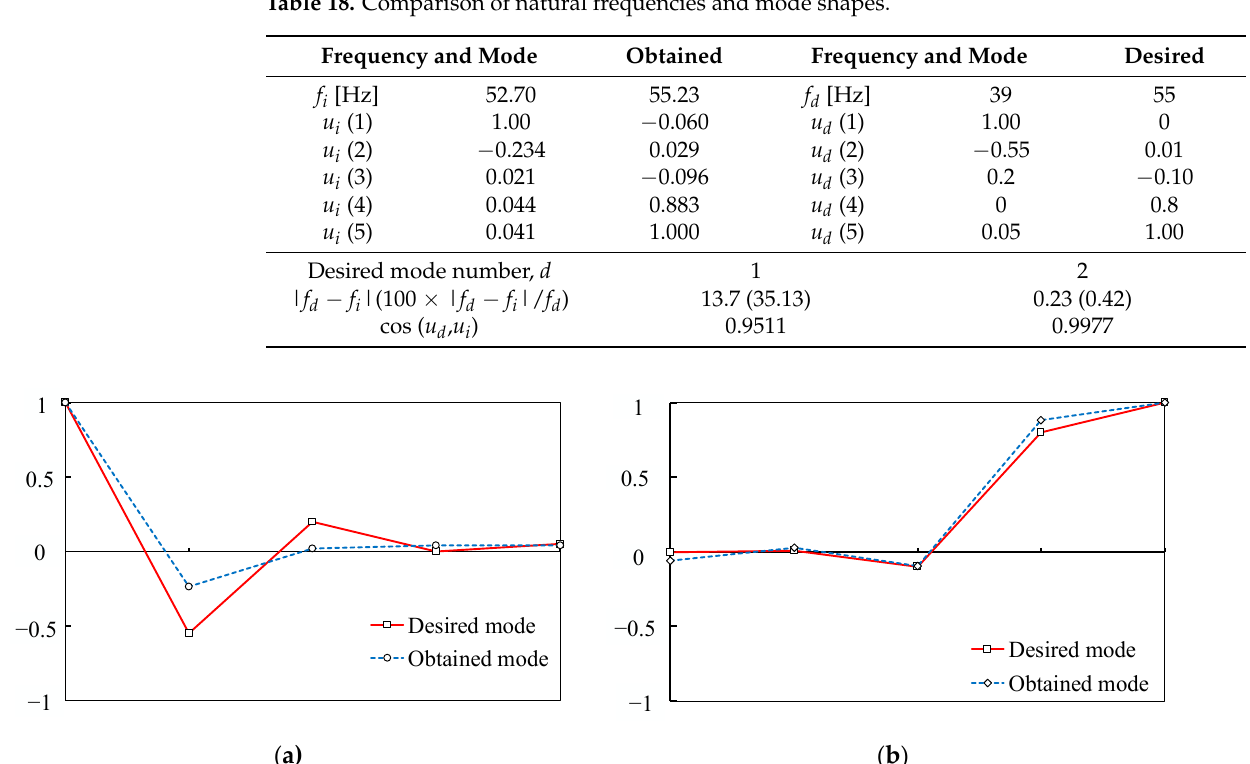
Figure 26. Original FRFs and the ones after adding supporting stiffness. Table 18. Comparison of natural frequencies and mode shapes.